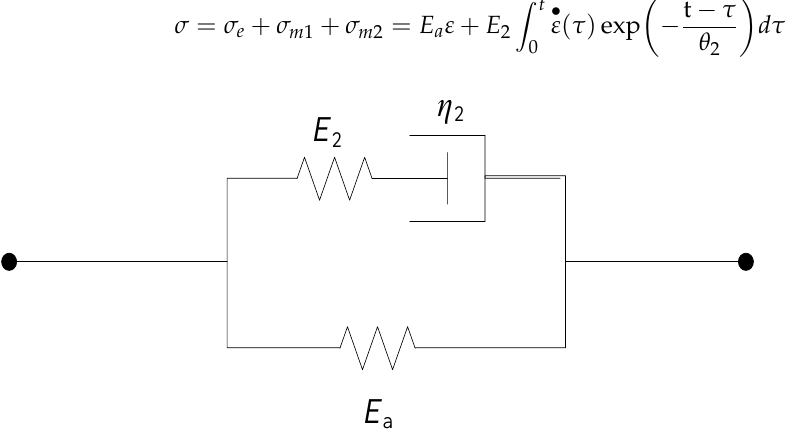
Figure 3. Equivalent constitutive model.